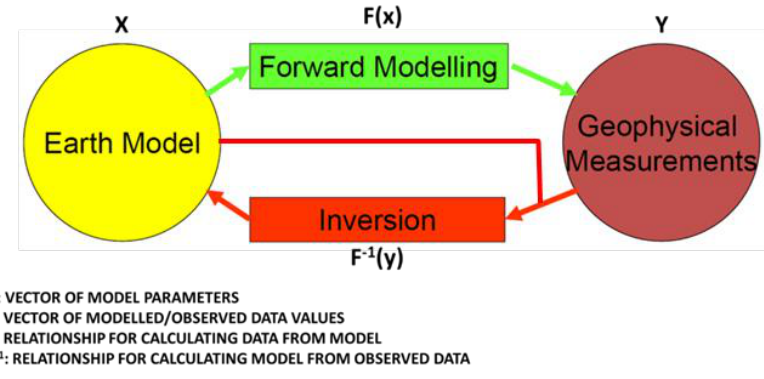
Figure 3—Project conceptual model